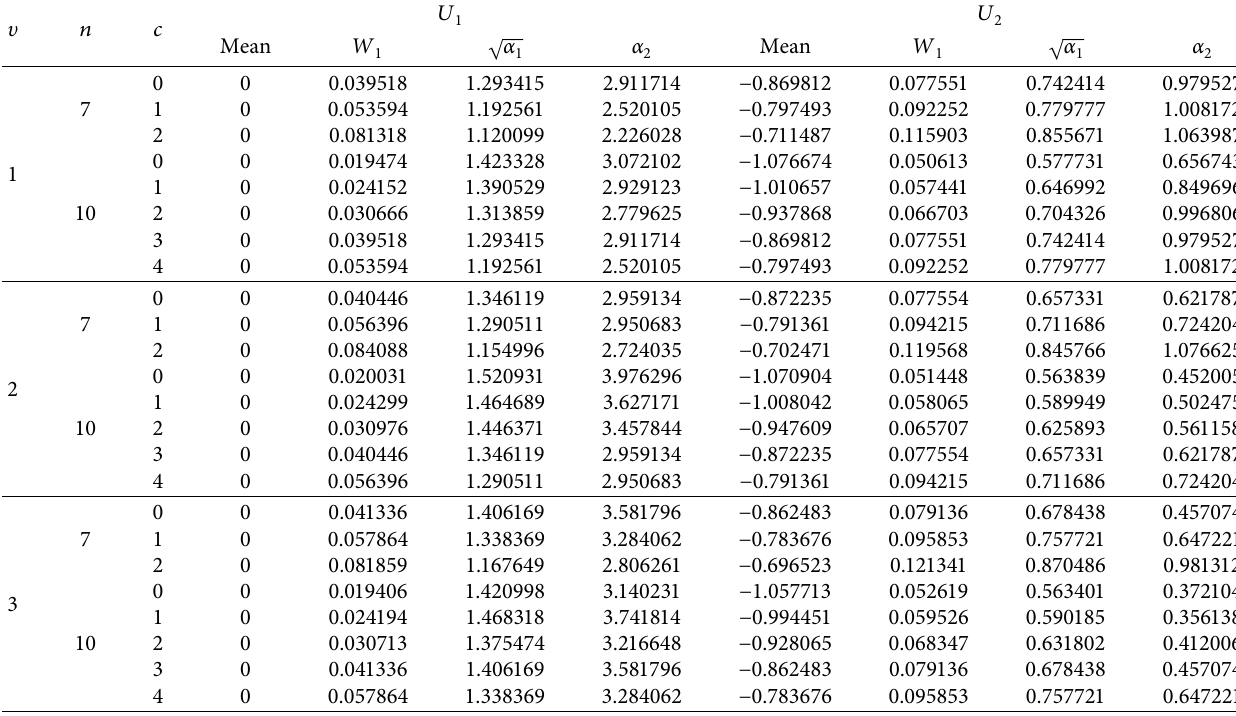
and U ∗ when μ � 0 and σ � 1 2